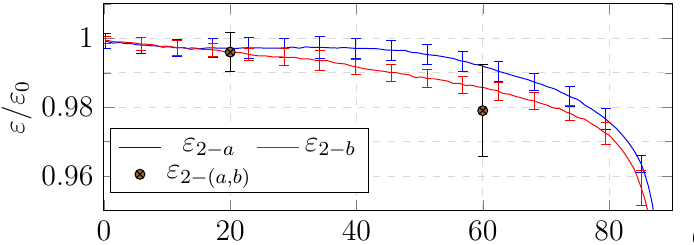
Figure 8. Nextel 6081 emissivity angle dependency for two different application methods for both relative and absolute